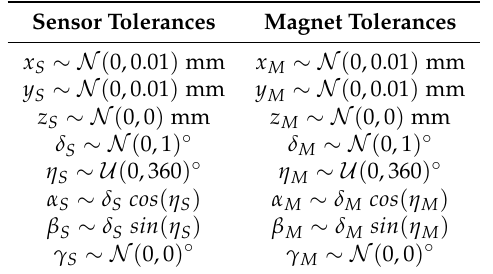
Table 2. Overview of assembly tolerances (eccentricities and tilts) for the sensor and magnet. Note that N ( 0,0.01 ) mm means an average of 0 mm and a variance of 0.01 mm 2 , which is equivalent to a standard deviation of 0.1